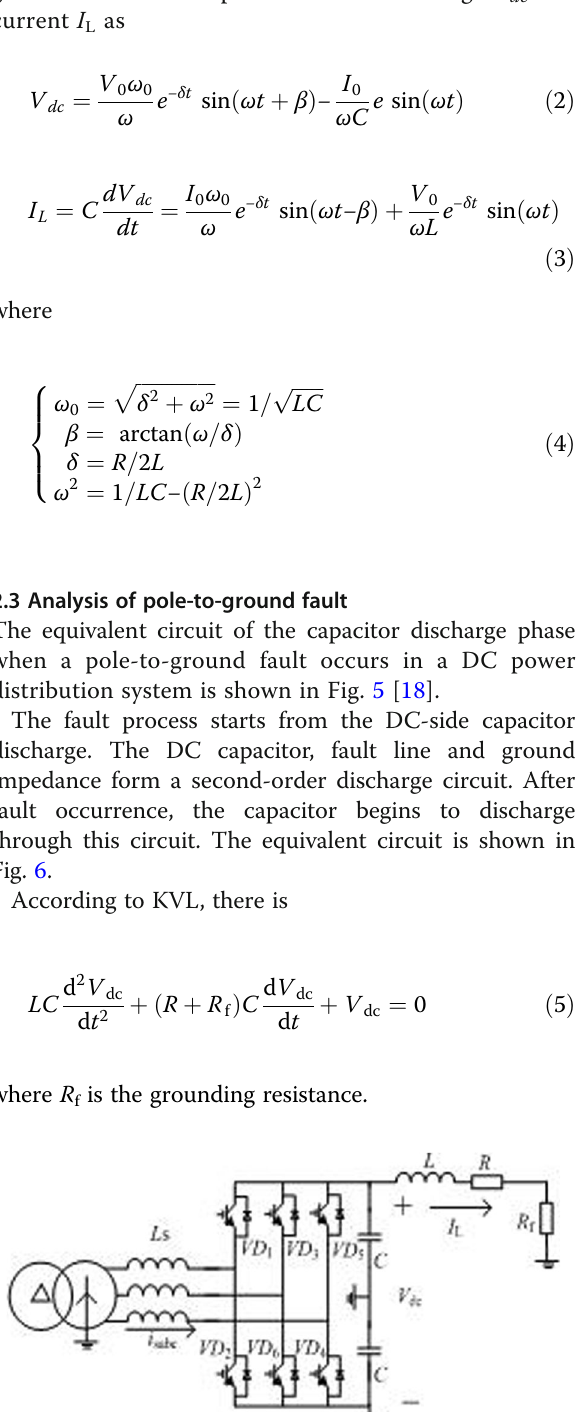
Fig. 4 Equivalent circuit diagram of capacitance discharge phase under pole-to-pole fault Fig. 5 Positive pole-to-ground fault